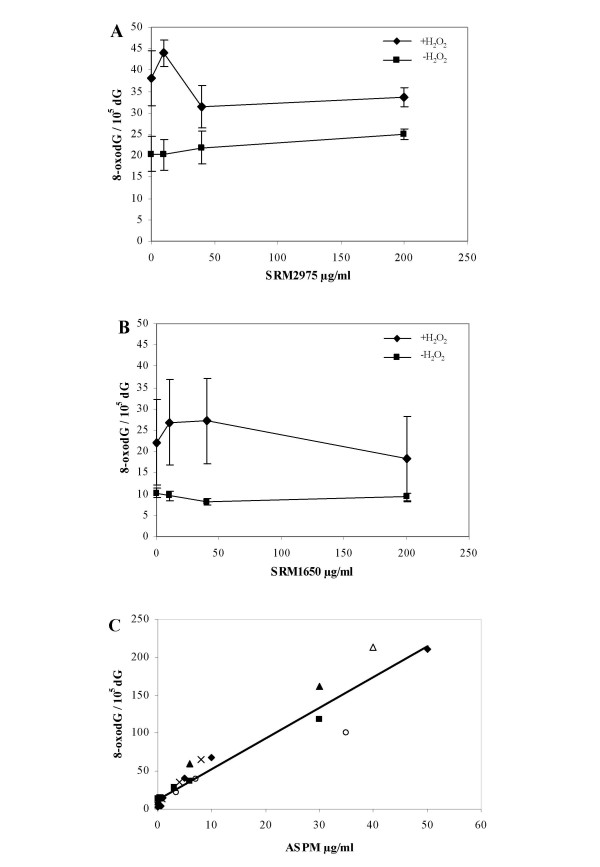
8-oxodG formation in calf thymus DNA measured with HPLC/ED after 30 minutes exposure to A) SRM2975 and B) SRM1650 and C) ASPM; ■ filter 1, ▲ filter 2, △ filter 3, ○ filter 4, ◆ filter 5. For SRM2975 and SRM1650 dots represents mean ± SEM; n = 3. The DNA was incubated at 37°C with 5 mM H2O2. For ASPM, the DNA was incubated at 37°C with 10 μM H2O2.